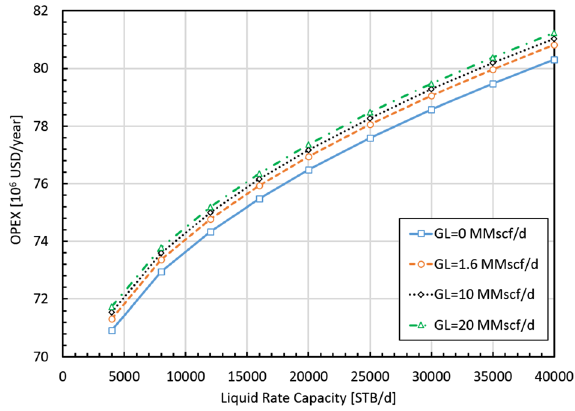
Fig. 17 Impact of each parameter on the project